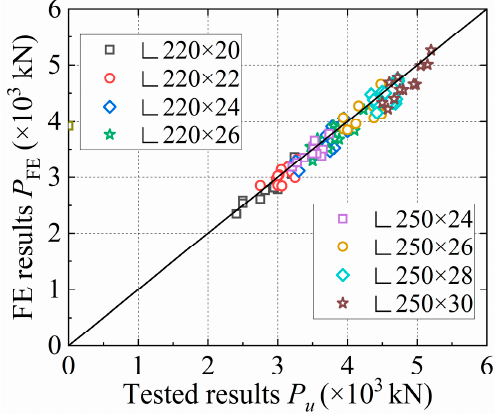
Figure 13. Comparison between FE results and tested results.